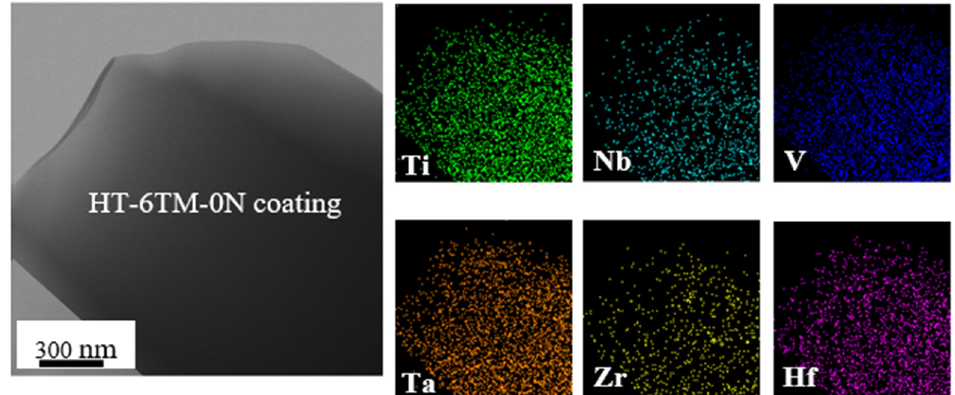
Figure 7. EDS mapping of the distribution of transition metal elements in the studied HiTUS– TiNbVTaZrHf-0N coating (~1705 nm thick).